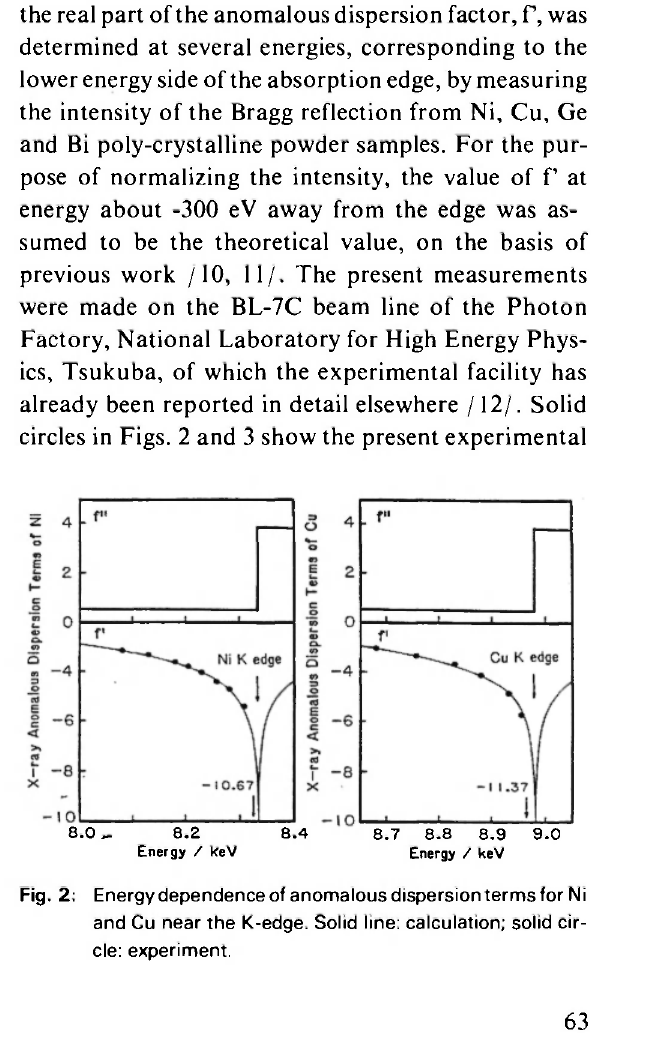
Fig. 2: Energy dependence of anomalous dispersion terms for Ni and Cu near the K-edge. Solid line: calculation; solid cir- cle: